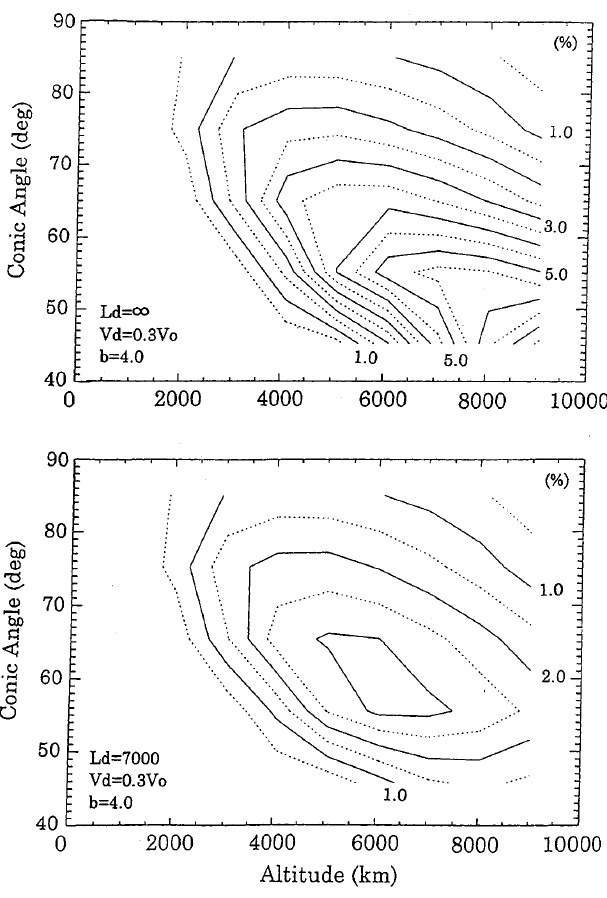
Fig. 7. A set of the calculated occurrence frequencies of ion conics which fit the observation results in Fig. 2 well. The upper panel is for geomagnetically active intervals and the lower for quiet